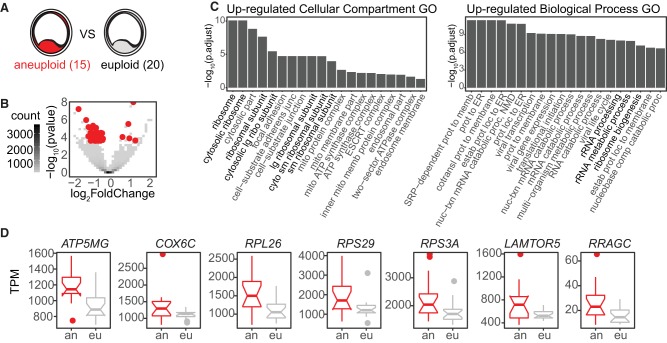
RNA-based karyotype-associated gene sets. (A) Schematic depicting RNA-based karyotype differential expression analysis: 15 aneuploid (by RNA) versus 20 euploid WE samples. (B) Volcano plot of differentially expressed genes from RNA-based karyotype differential expression analysis. Red indicates significant differential expression (BH-adjusted P-value <0.05). (C) Gene Ontology (GO) enriched terms for genes up-regulated in the aneuploid samples: (left) cellular compartment; (right) biological process. (D) Boxplots of selected differentially expressed genes from the RNA-based karyotype differential expression analysis (BH-adjusted P-value <0.05). Aneuploid samples are in red; euploid samples, in gray.